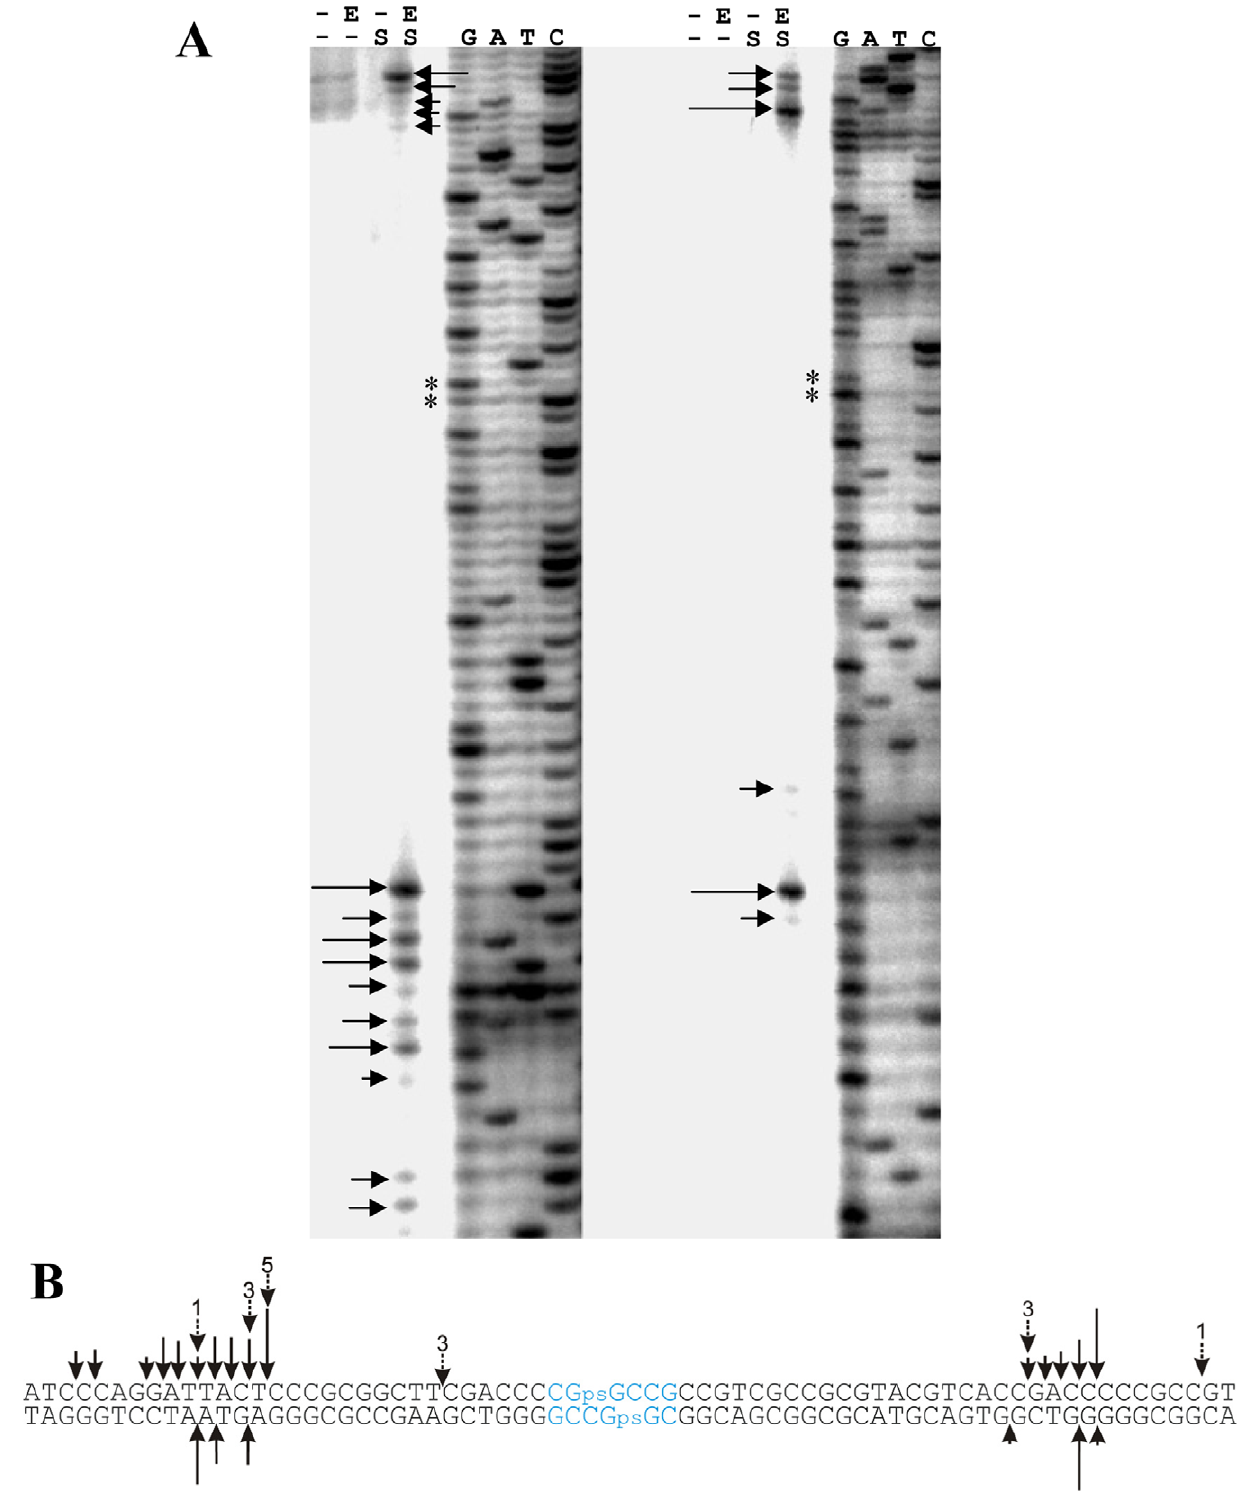
Figure 7. Invitro cleavage of a synthetic S-modified (phosphorothioated) double-stranded 118 bp oligonucleotide by purified His 6 - Sco4631. A. Autoradiographs of 5 9 labeled top strand DNA (left) and 5 9 labeled bottom strand DNA (right). G, A, T, C denote the sequencing ladders. Horizontal arrows indicate cleavage sites, and ** indicates the tandem G residues linked by a phosphorothioate bond. His 6 -Sco4631-mediated cleavage was observed exclusively in the samples of S-modified DNA (S) that also contained active His 6 -Sco4631 (E). Samples without DNA S modification or containing heat-inactivated His 6 -Sco4631 were not cleaved. - indicates the absence of enzyme or S-modification, respectively. B. In vitro cleavage of S-modified DNA by His 6 -Sco4631. Vertical arrows indicate bonds where cleavage of the 118 bp oligonucleotide was observed. The length of the solid arrows indicates the intensity of the bands in panel A and thus the frequency of cleavage. Dotted arrows indicate in vitro generated cleavage sites of pHZ209 (see Figure 5). The preferred S-modification sequence CGpsGCCG is shown in blue.